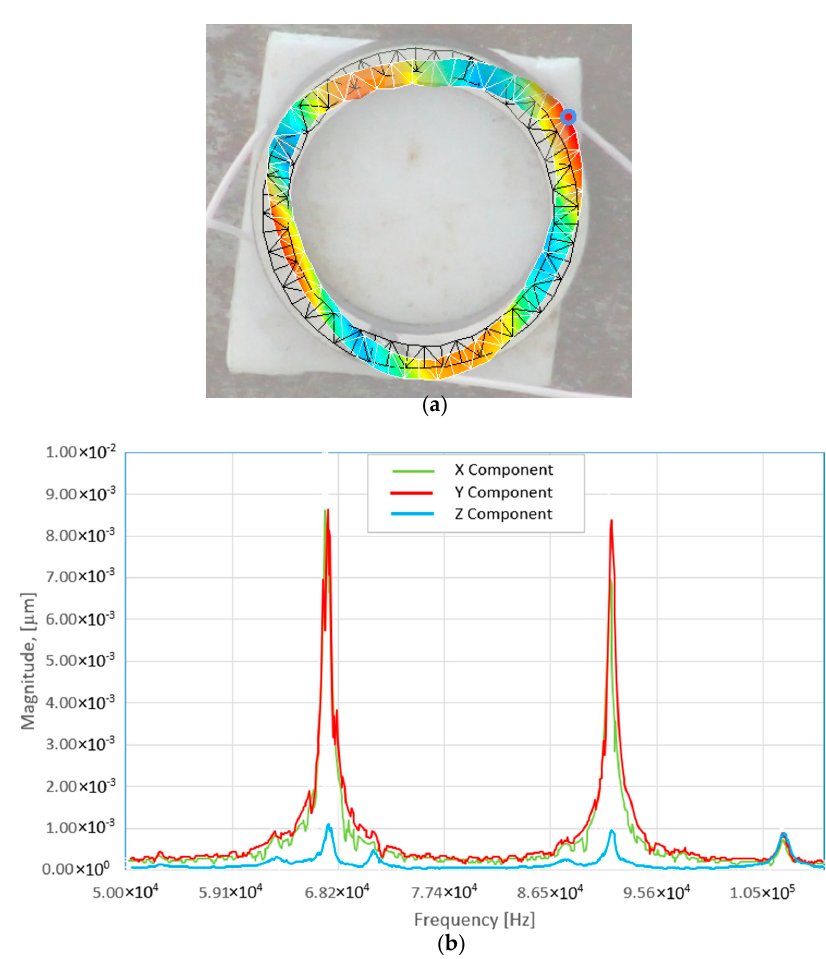
Figure 12. Measured vibrations of the piezoelectric transducer glued on the soft rubber tape: ( a ) prototype deformations and shape of the transducer driven with harmonic electric signal of the 92.48 kHz; ( b ) amplitude vs. frequency graph, peaks of oscillations at 61 and 92.48 kHz.